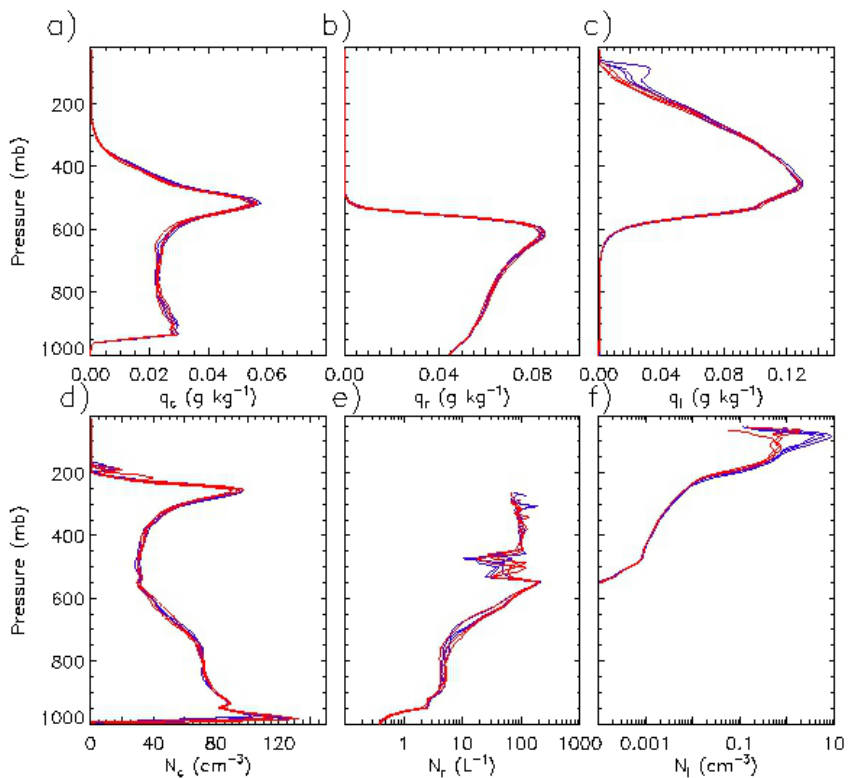
Fig. 9. As in Fig. 6, except for profiles of horizontally-averaged (a) cloud water mixing ratio, q c , (b) rain mixing ratio, q r , (c) ice mixing ratio, q i , (d) cloud droplet concentration, N c , (e) rain number concentration, N r , and (f) ice number concentration, N i . Presented results are averaged between 12:00UTC 19 January to 12:00UTC 25 January. Number concentrations are averaged over grid cells with mixing ratio greater than 0.001gkg − 1 for the given hydrometeor